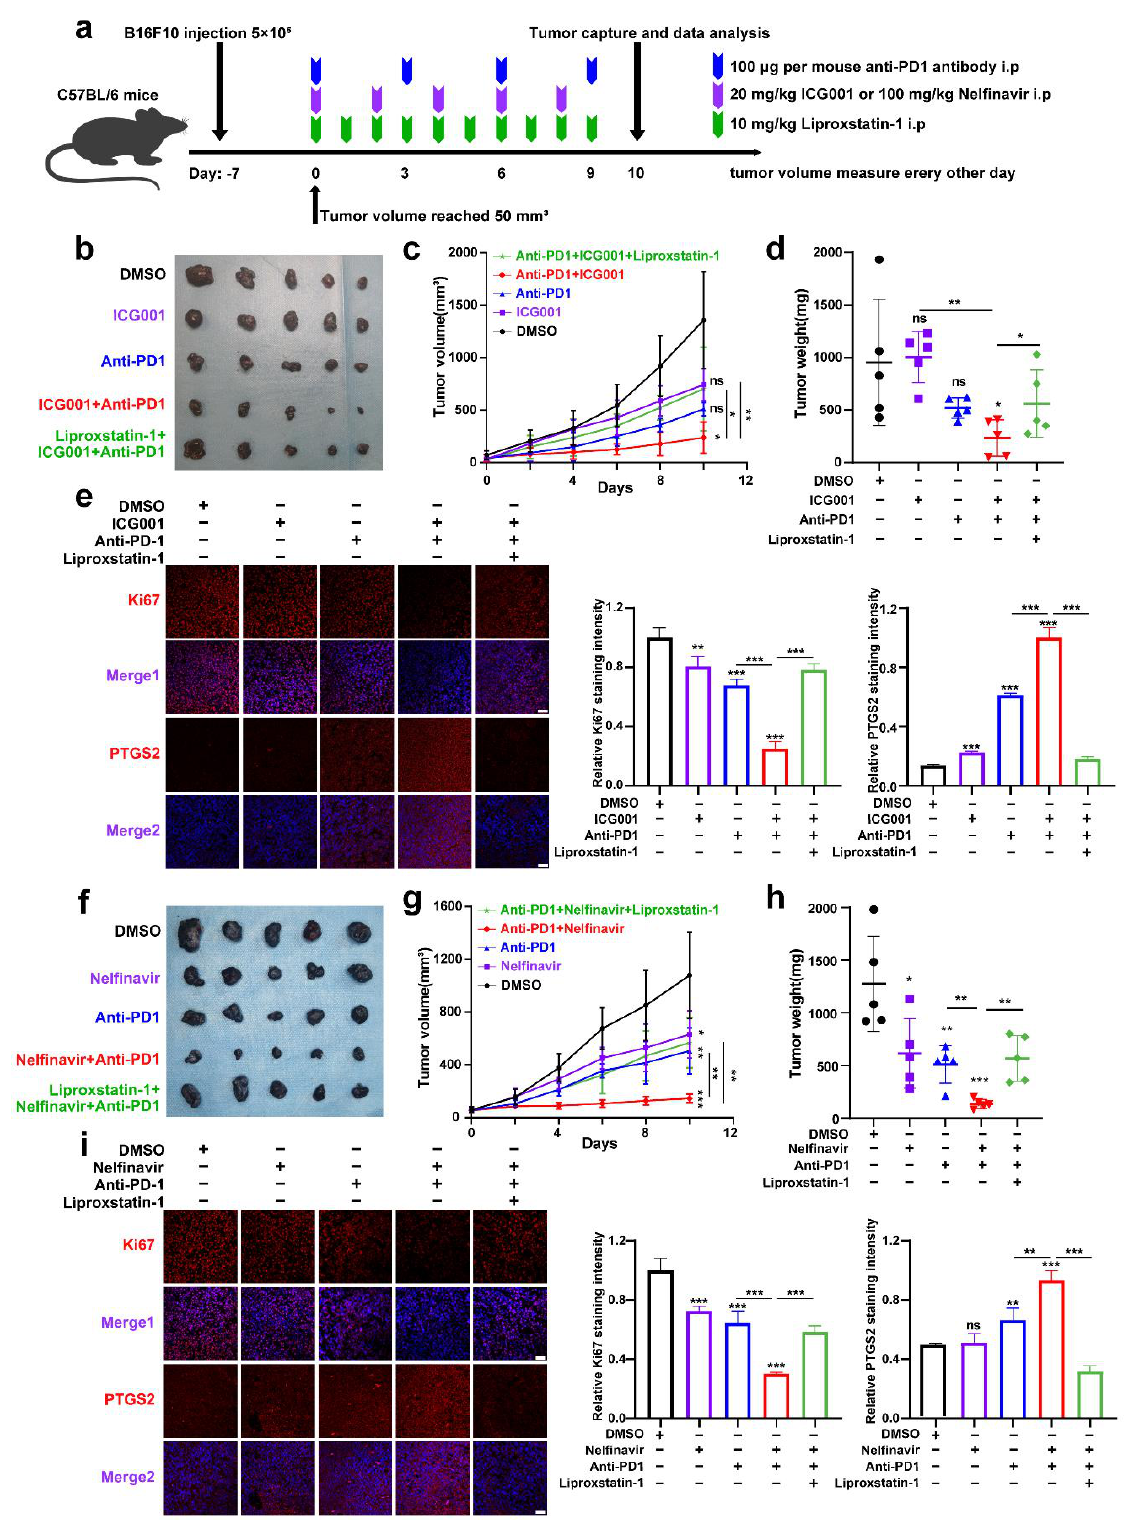
Figure 6. Targeting Wnt/ β -catenin and MITF increases the effectiveness of anti-PD-1 antibodies partially via the induction of ferroptosis. ( a ) An illustration of the treatment strategy. ( b – d ) Pictures of isolated tumors from xenograft mice that received pharmacological inhibition of Wnt signaling and anti-PD- 1 antibody treatment. Each group’s volumes and weights of tumors were computed and are shown in the right panel. ( e ) IF staining of PTGS2 and Ki-67 in isolated xenograft tumors with the indicated treatment related to ( b ). Scale bar = 50 μm. ( f – h ) Images of isolated tumors from xen- ograft mice that received pharmacological inhibition of MITF and anti-PD-1 antibody treatment. Each group’s volumes and weights of tumors were computed and are shown in the right panel. ( i )